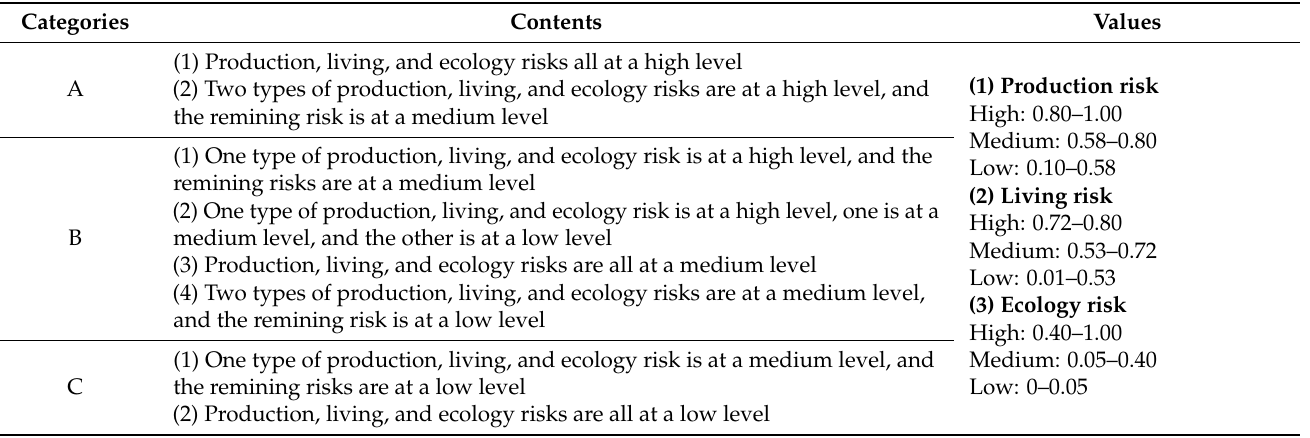
Table 1. Contents of categories to cope with PLE